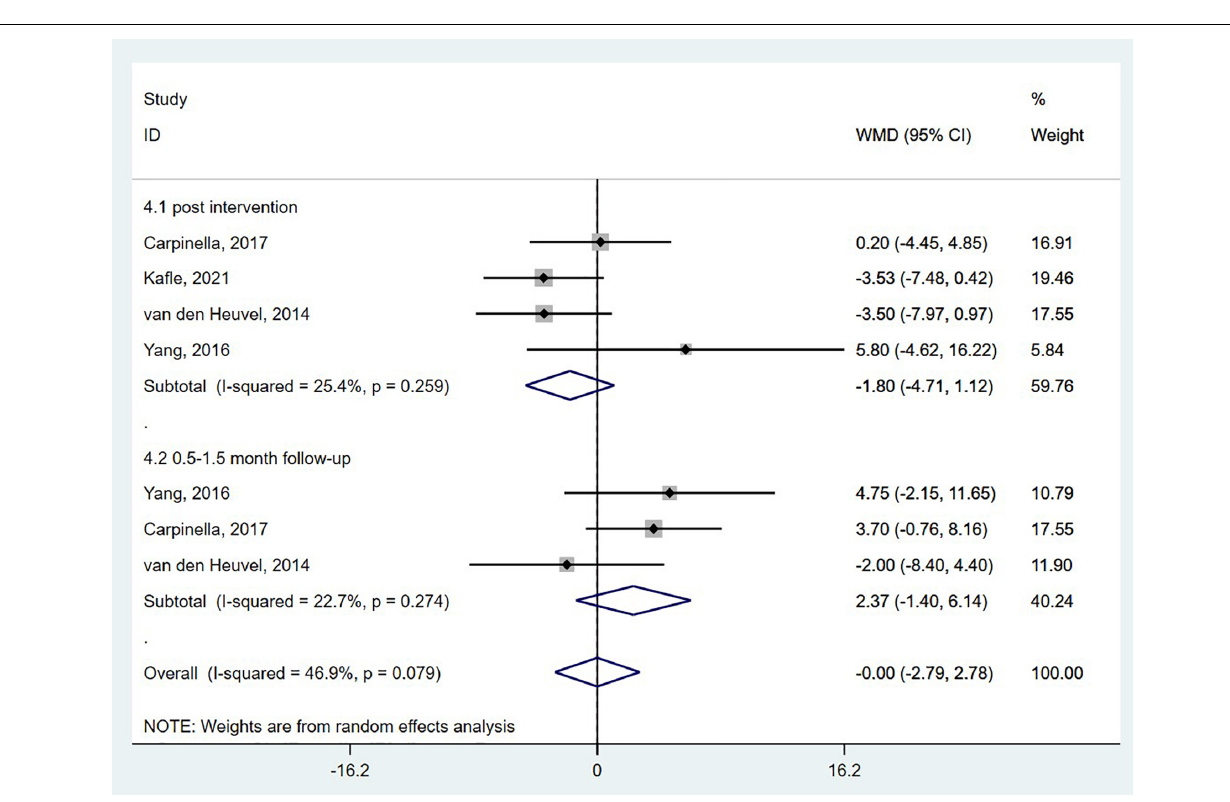
Frontiers in Aging Neuroscience |